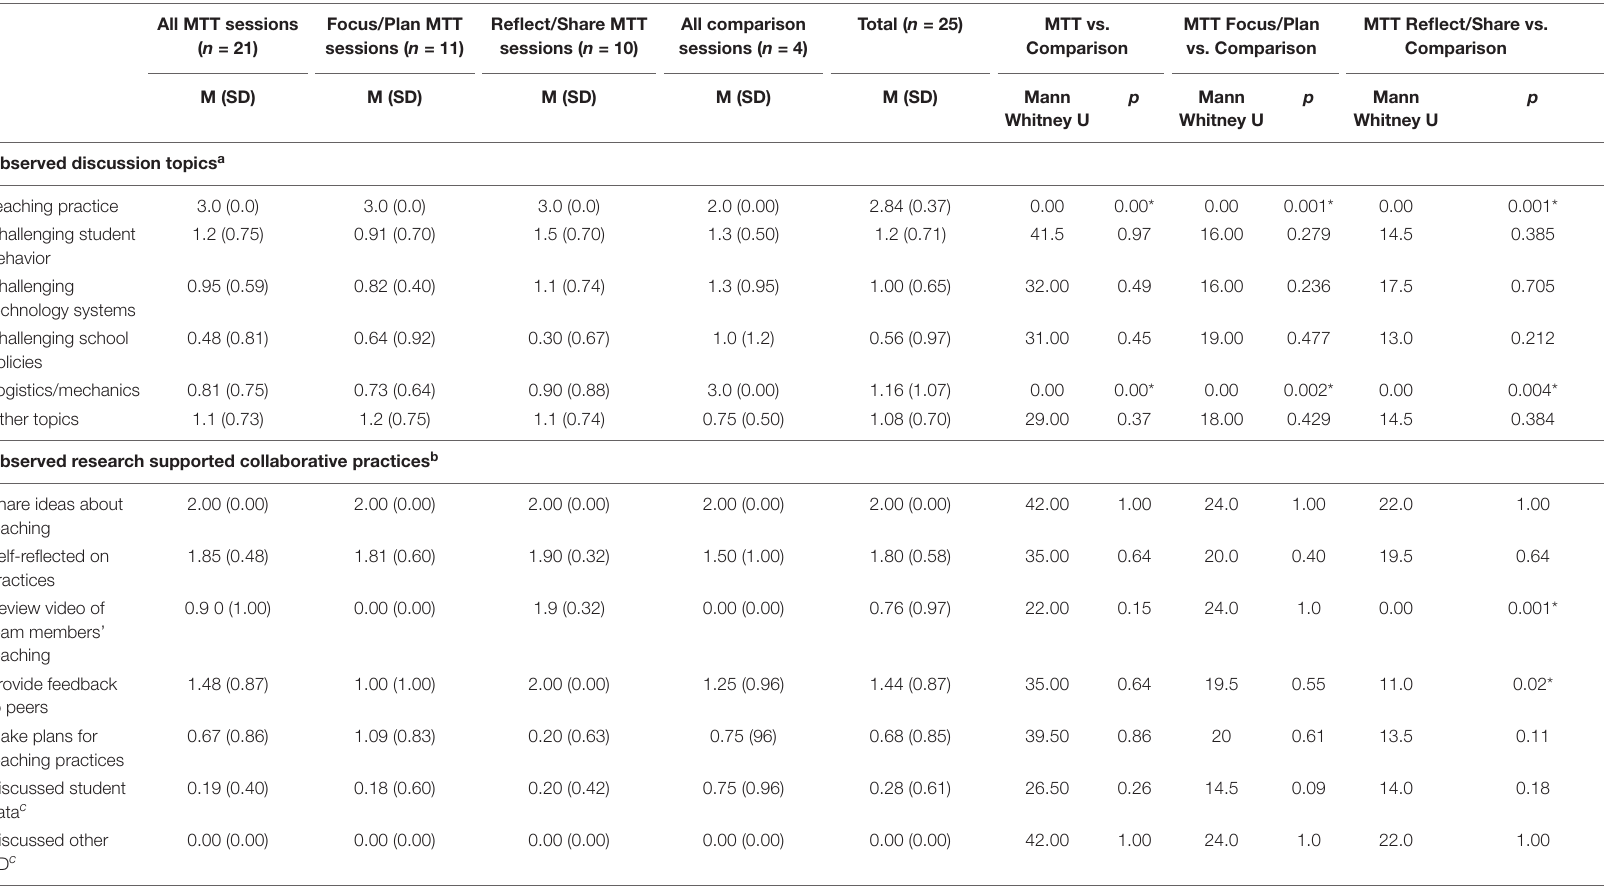
TABLE 5 | Observed discussion topics and research supported collaborative practices for MTT and comparison group